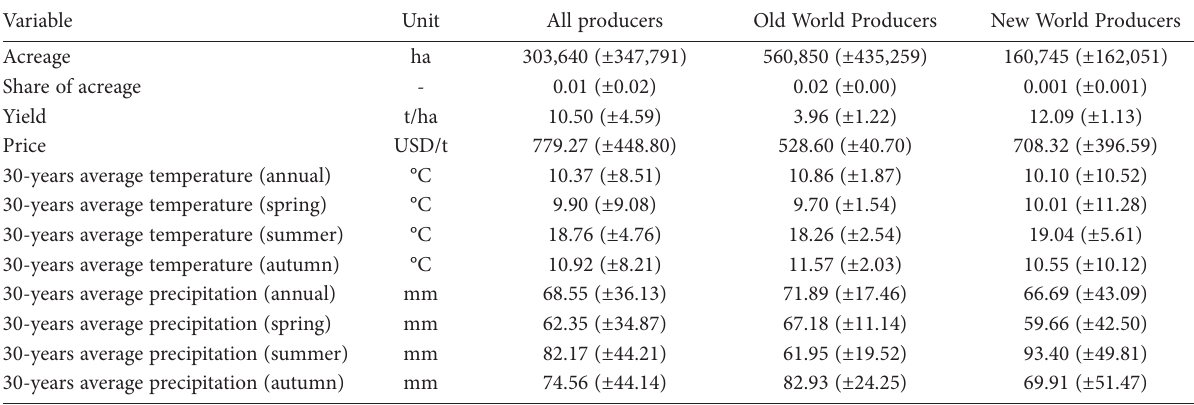
Table 1. Descriptive statistics for key